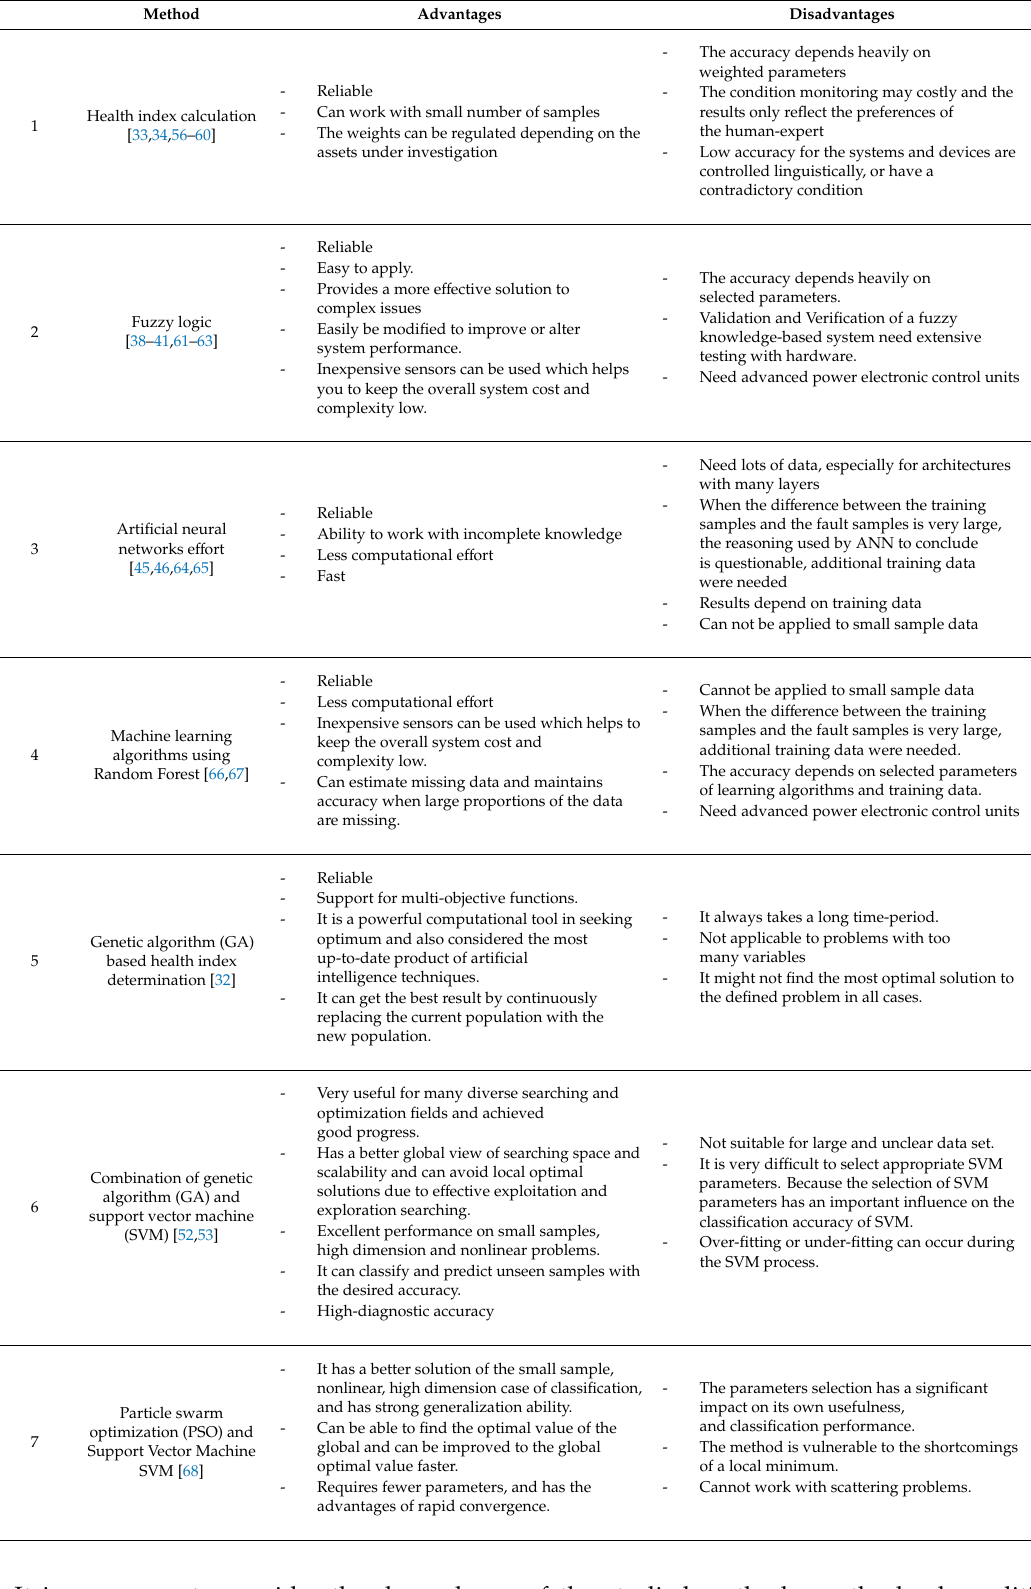
Table 4. Advantages and disadvantages of transformer’s health assessment